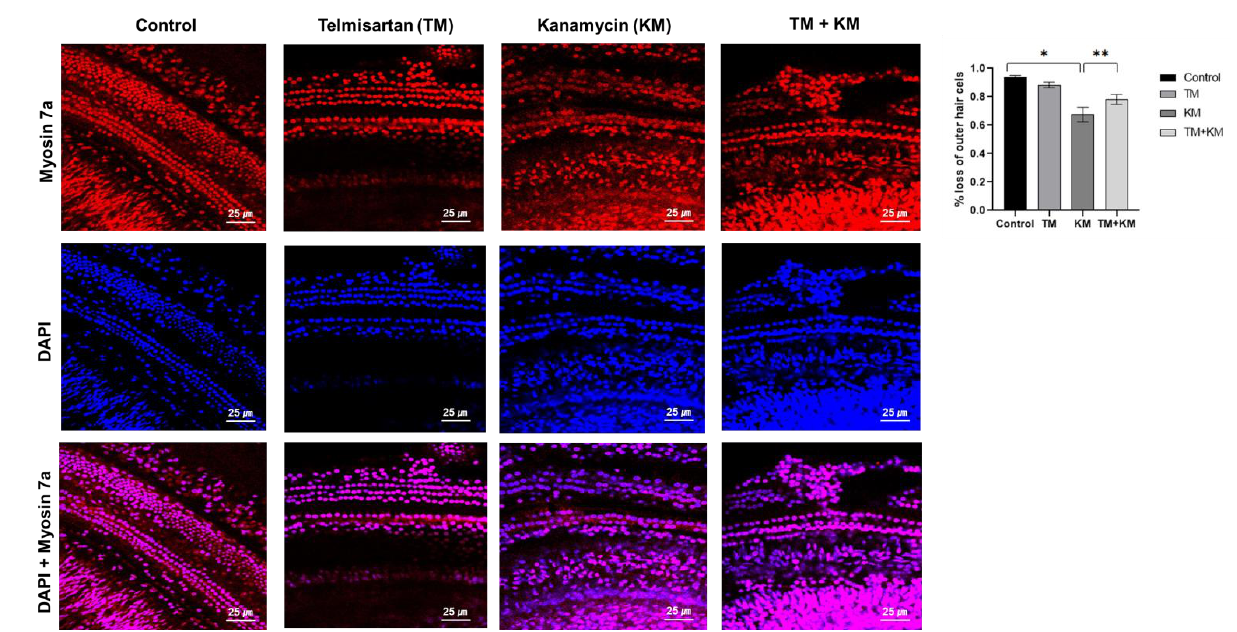
Figure 3. The cochlear whole-mount (Red: myosin7A-positive cells; Blue: DAPI-positive cells; Purple: myosin7A and DAPI-positive cells). The KM + KM group showed smaller changes in the loss of outer hair cells than the KM group. * p < 0.05 unpaired t -test between THE control and KM groups, ** p < 0.05 in unpaired t -test between KM and KM + TM groups.